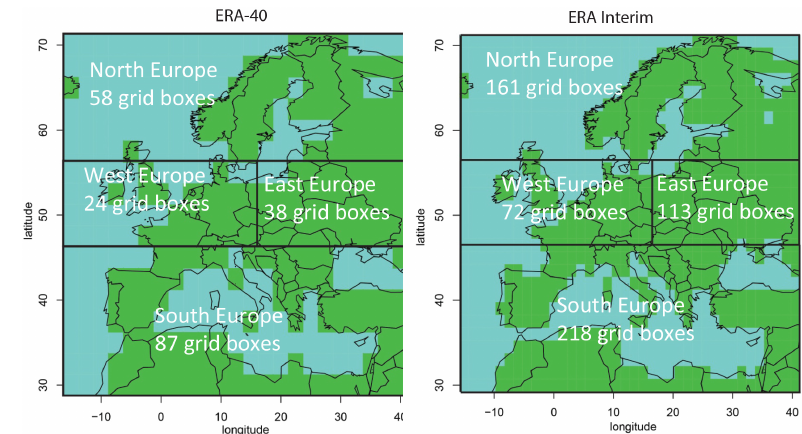
Figure 1. The four European regions analysed for ERA-40 (left panel) and ERA Interim (right panel) data